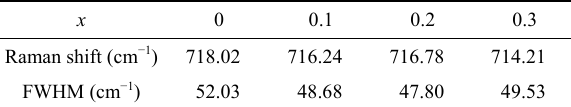
Table 2 Raman shifts and full widths at half maximum (FWHMs) of stretching mode at about 718 cm − 1 obtained by Raman spectra